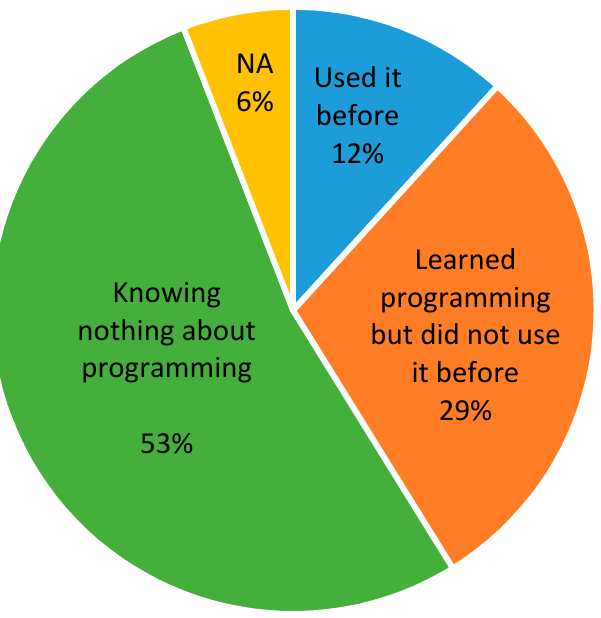
Figure 5. Programming skills of the RCMI researchers, postdoctoral fellows, residents, staff, and graduate students engaged in data science training.